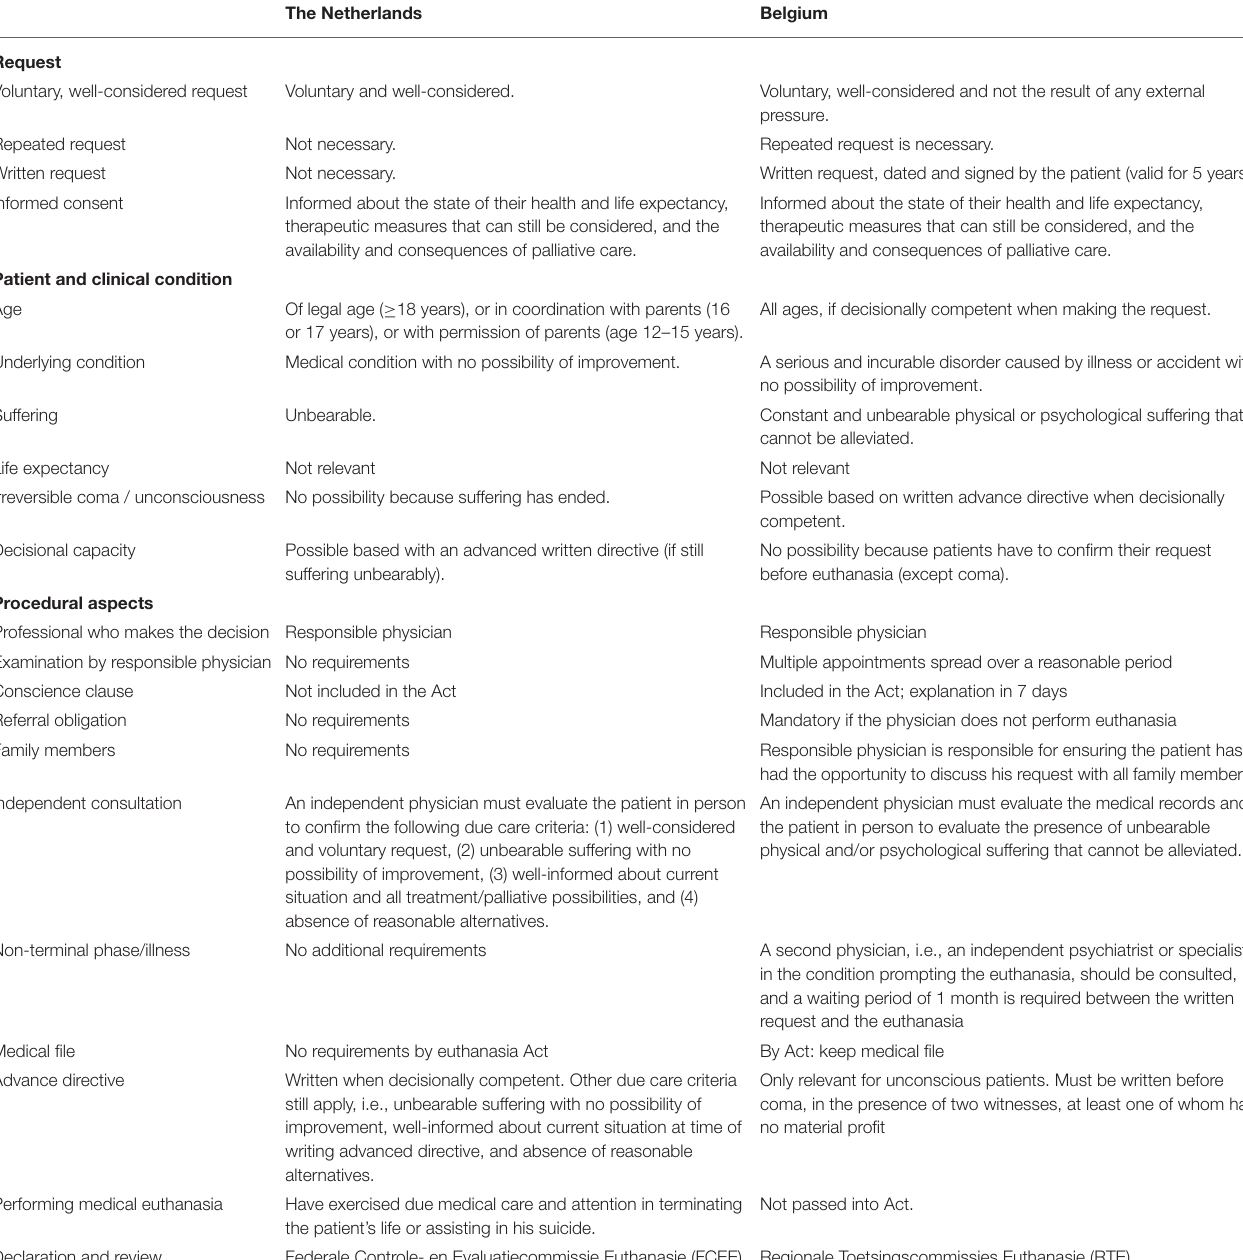
TABLE 1 | Differences and similarities in euthanasia in the Netherlands and Belgium. The Netherlands